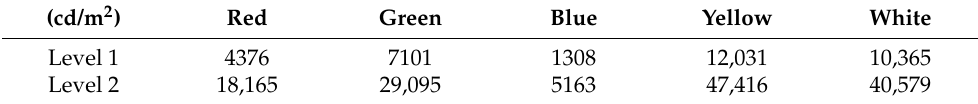
Table 2. Luminance (cd/m 2 ) of five colors (through a half-mirror).